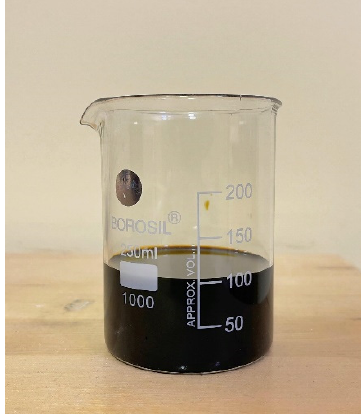
Figure 2. Processed oil.